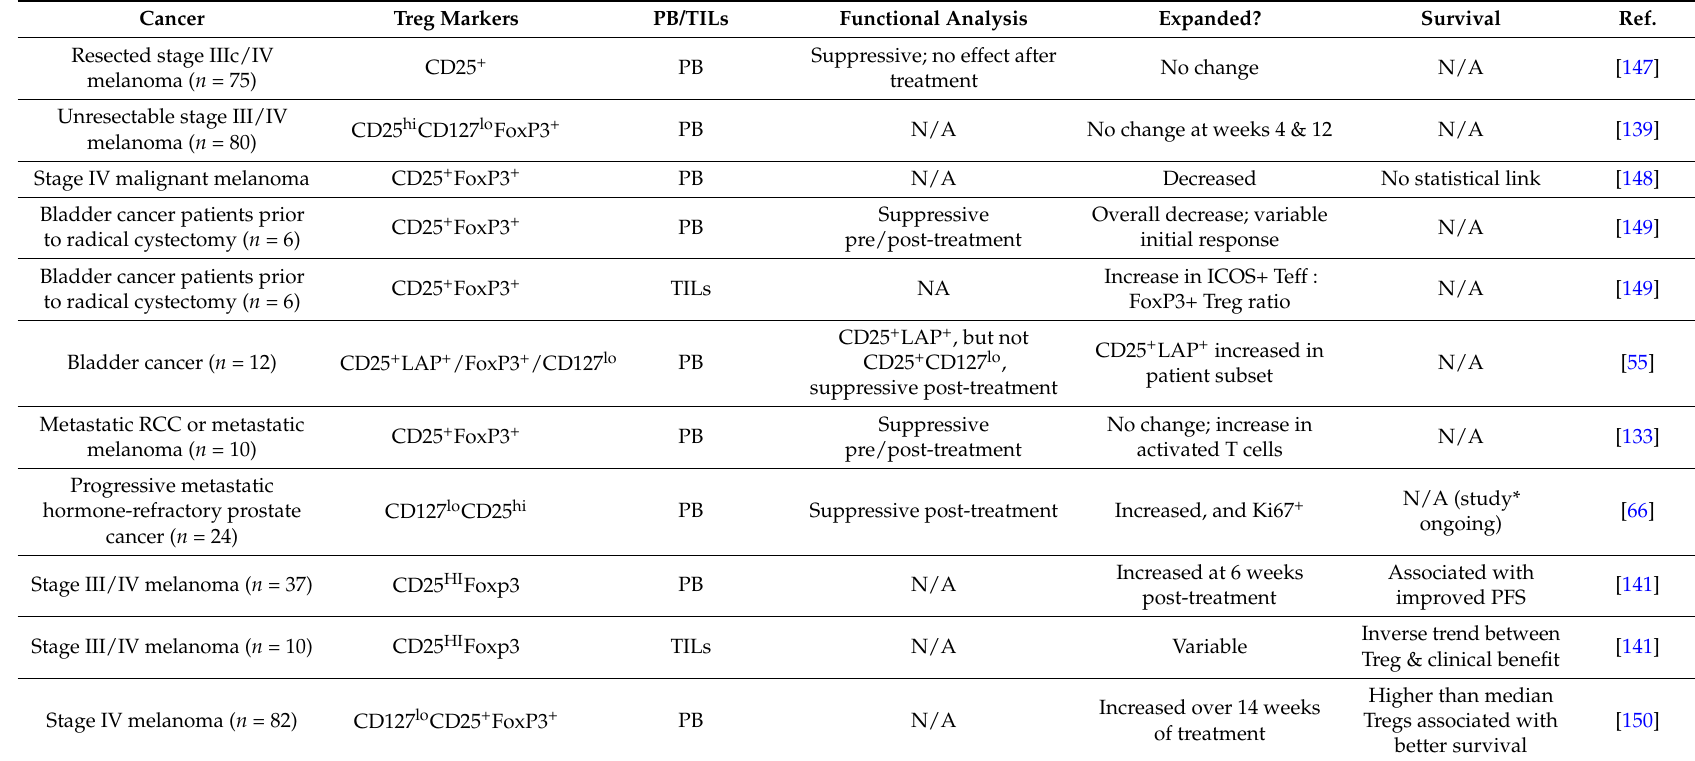
Table 2. Clinical studies investigating the impact of ipilimumab on